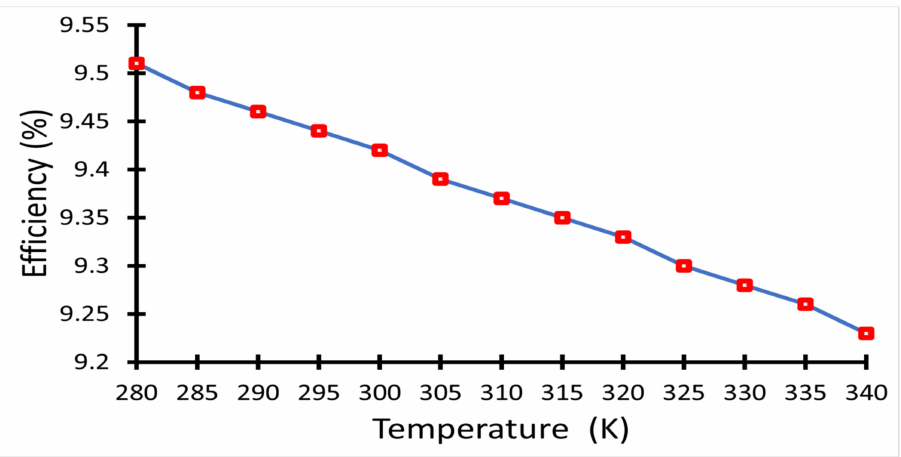
Figure 7. PCE of the solar cell as a function of